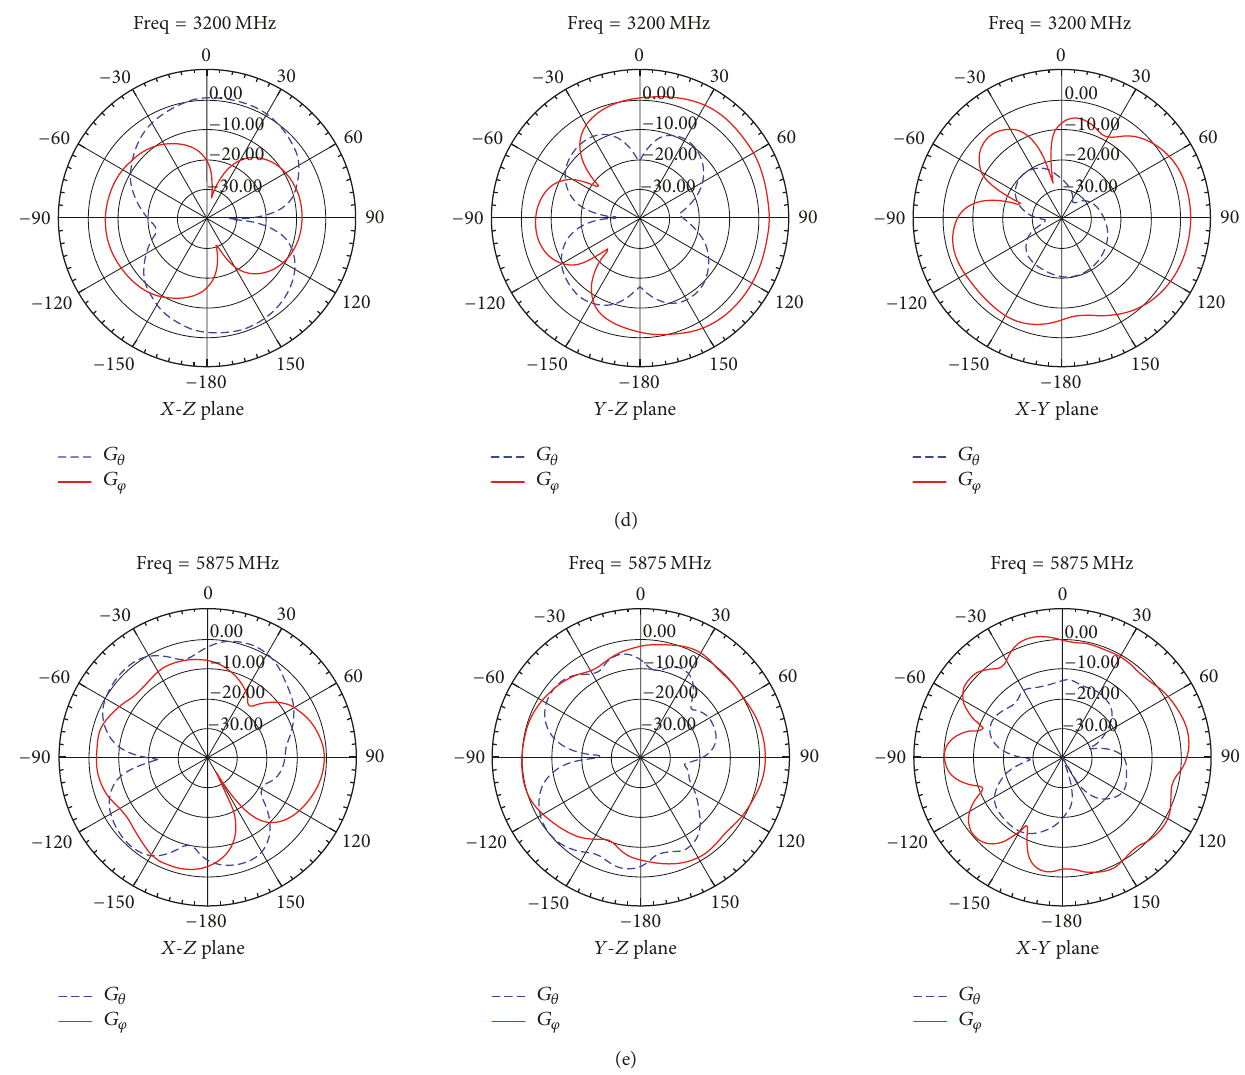
Figure 3: Measured gain radiation patterns at (a) 915MHz; (b) 1575 MHz; (c) 2450 MHz; (d) 3200 MHz; and (e) 5875 MHz.